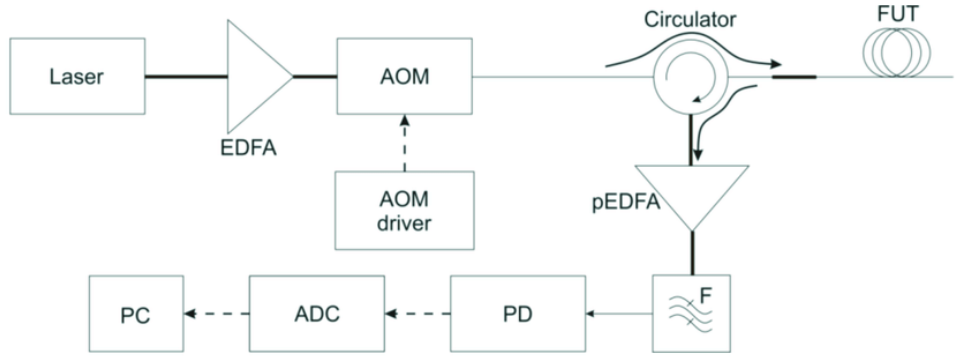
Figure 7. The experimental setup of a φ -OTDR system.